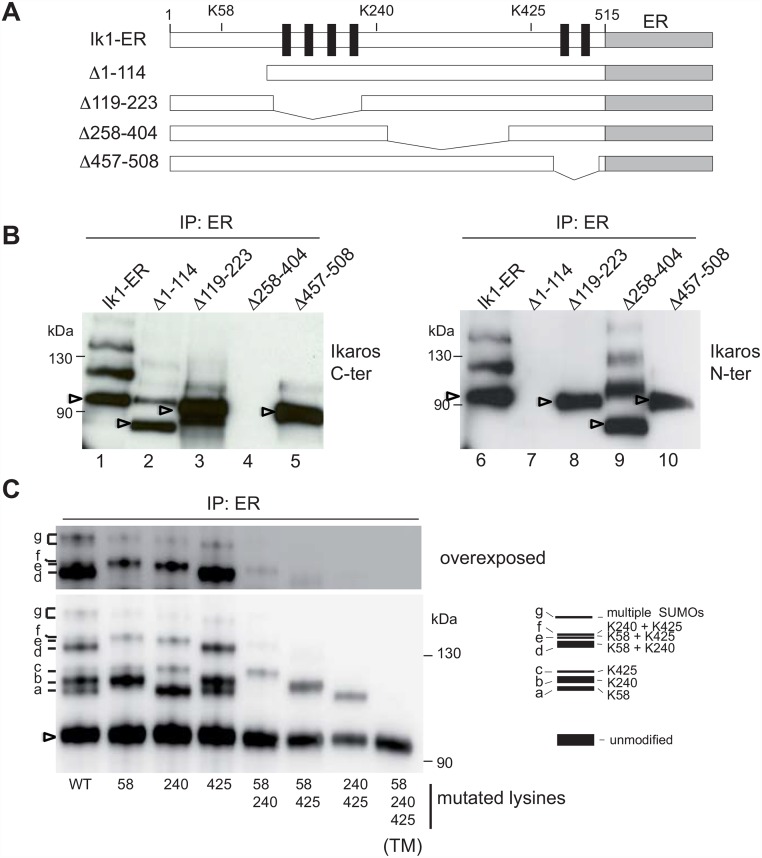
Impact of Ikaros mutations on sumoylation.(A) Schematic representation of Ik1-ER deletion mutants. (B) Modification pattern of Ik1-ER deletion mutants. ILC87 cells expressing Ik1-ER or deletion mutants were treated and lysed as described in Fig 1D. Nuclear extracts were immunoprecipitated with an anti-ER antibody, separated by SDS-PAGE (6%) and analyzed with anti-Ikaros antibodies against C-terminal or N-terminal epitopes. (C) Nuclear extracts from 50x106 ILC87 cells expressing Ik1-ER or the indicated point mutants were immunoprecipitated with an anti-ER antibody, separated on a NuPAGE Novex 3–8% Tris-Acetate gel and analyzed with an anti-Ikaros antibody. The pattern of the various modified proteins is schematized on the right and the corresponding modifications indicated. In (B) and (C), arrowheads point to unmodified proteins.